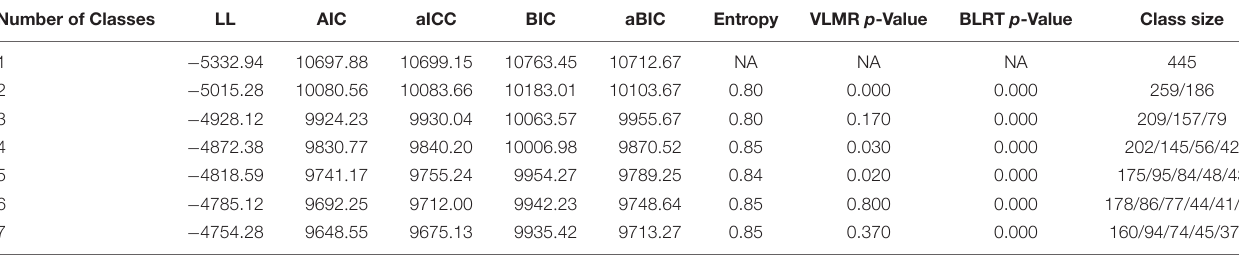
TABLE 2 | Summary of different class solutions from latent profile analysis (LPA).